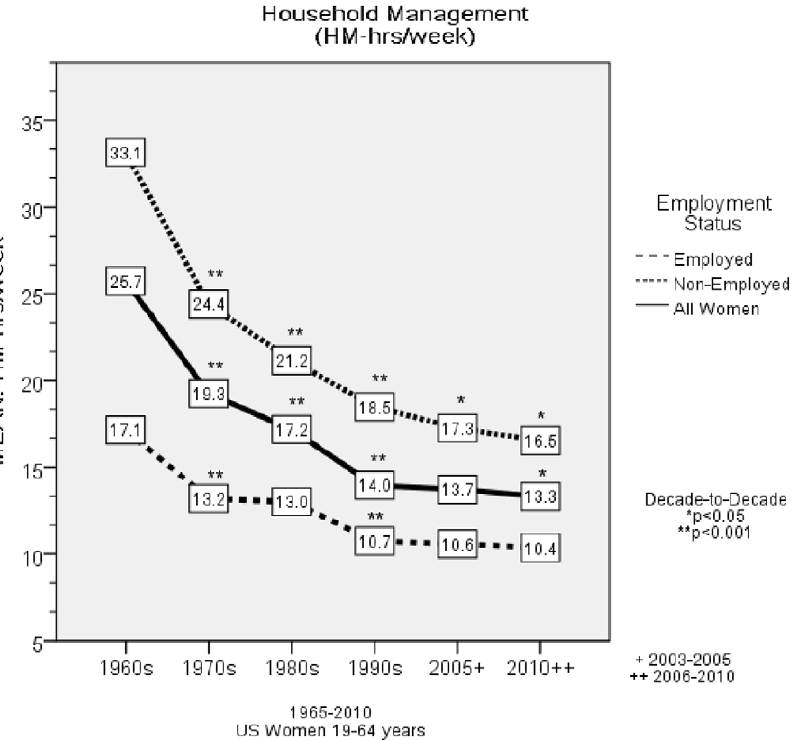
Figure 1. Household Management Hours per Week by Employment Status. This figure depicts the decade to decade changes in Household Management Hours per Week (HM-hr/week) for all women and by employment